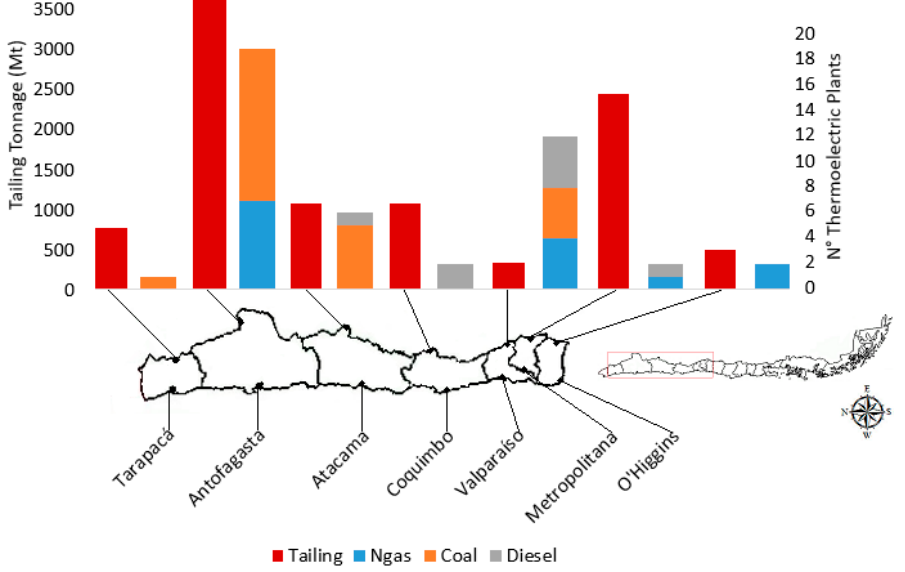
Figure 3. Distribution of active tailing deposits and thermoelectric plants in Chile by region.